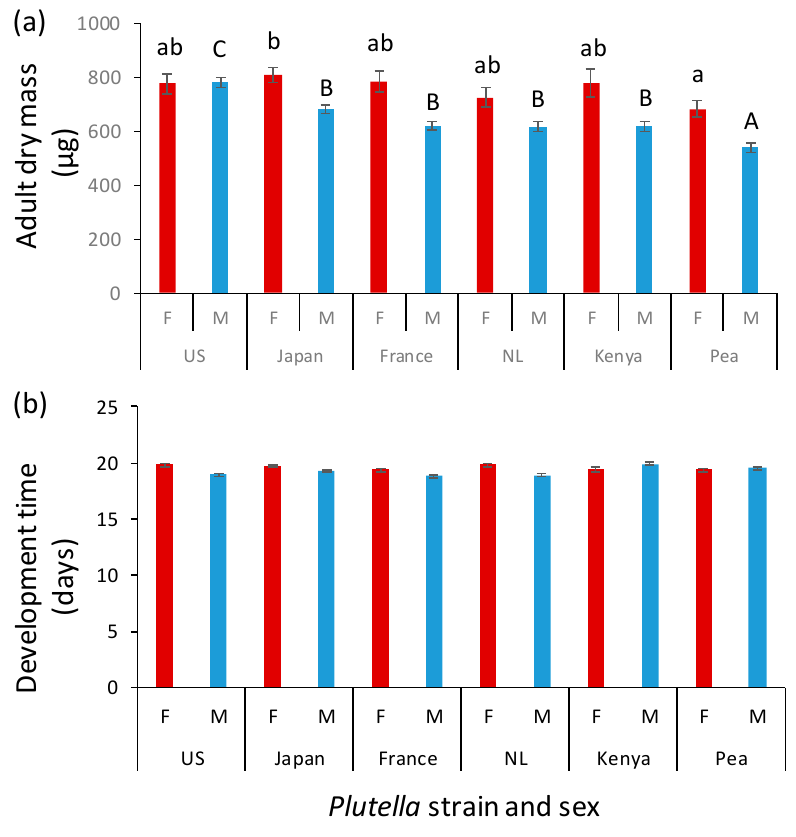
Figure 4. Mean ( ± SE) adult dry mass ( a ) and egg-to-adult development time ( b ) of female (red bars) and male (blue bars) Diadegma semiclausum developing from Plutella xylostella populations originating from the US, Japan, France, the Netherlands (NL) and Kenya, as well as a population adapted to pea in Kenya. Eleven parasitized caterpillars of each population were introduced on each of 10 Brassica rapa plants. Bars with the same letter are not significantly different. Data were analyzed separately for females (small letters) and males (capital letters).